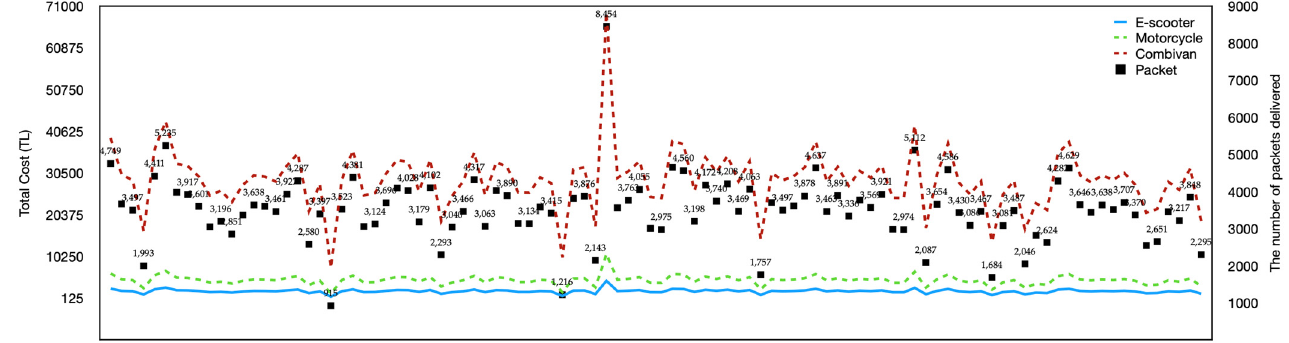
Figure 4. The total cost for a package delivered.